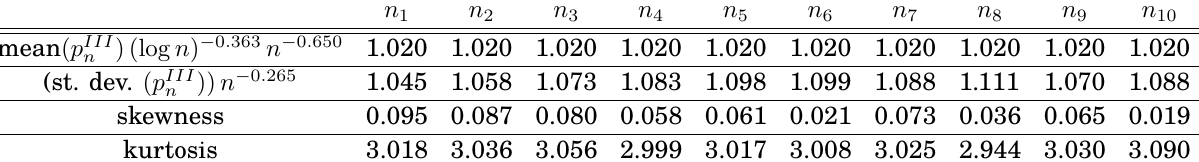
Table 5: Monte Carlo simulation results for the model-III.